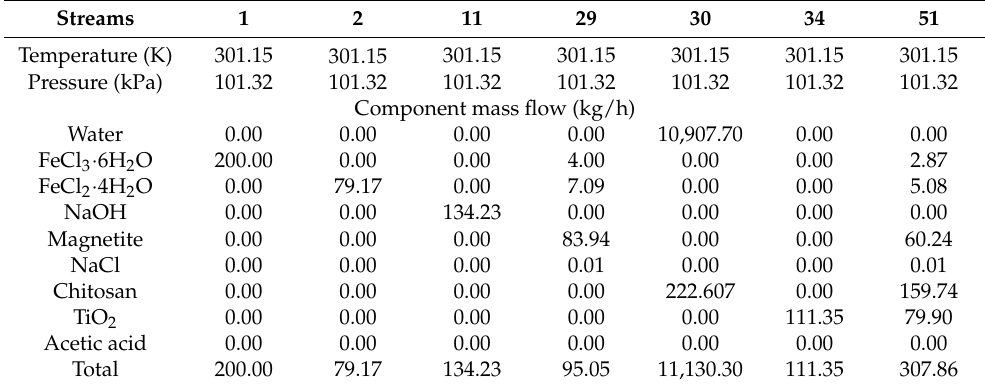
Table 3. Main process streams for chitosan microbeads modified with TiO 2 and magnetite nanoparticles. Streams